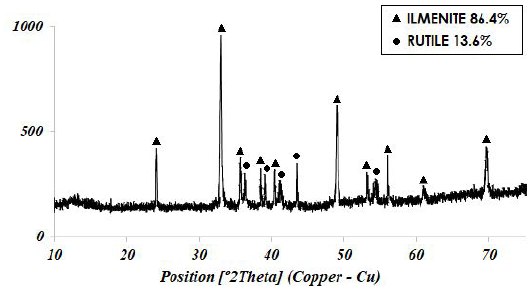
Figure 1. X-ray diffractometry spectrum refined by Bruker AXS software.